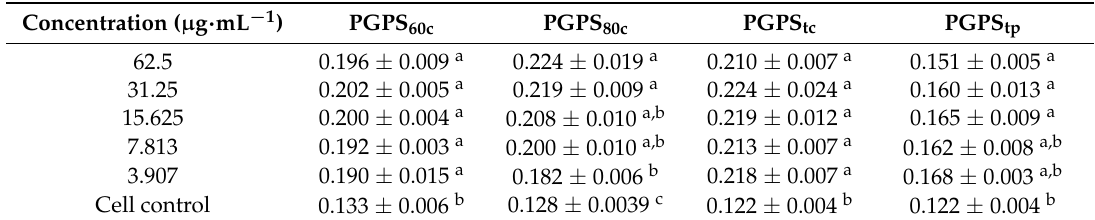
Table 2. Changes in OD 570 value of peripheral lymphocyte proliferation of each group in single stimulation with Platycodon grandiflorum polysaccharides (PGPSs) (OD 570 value) ( n = 4). Concentration ( µ g · mL − 1 )